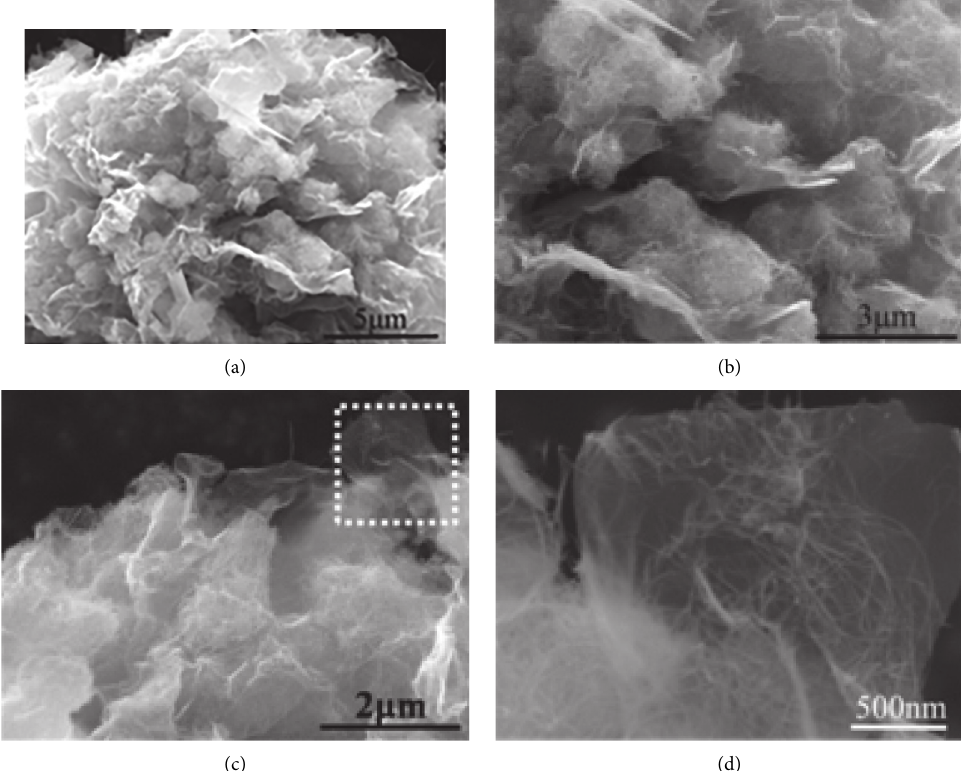
Figure 1: (a)–(c) The SEM images of the GTNTcomposites with different multiples. (d) The enlarged SEM images of the white box in